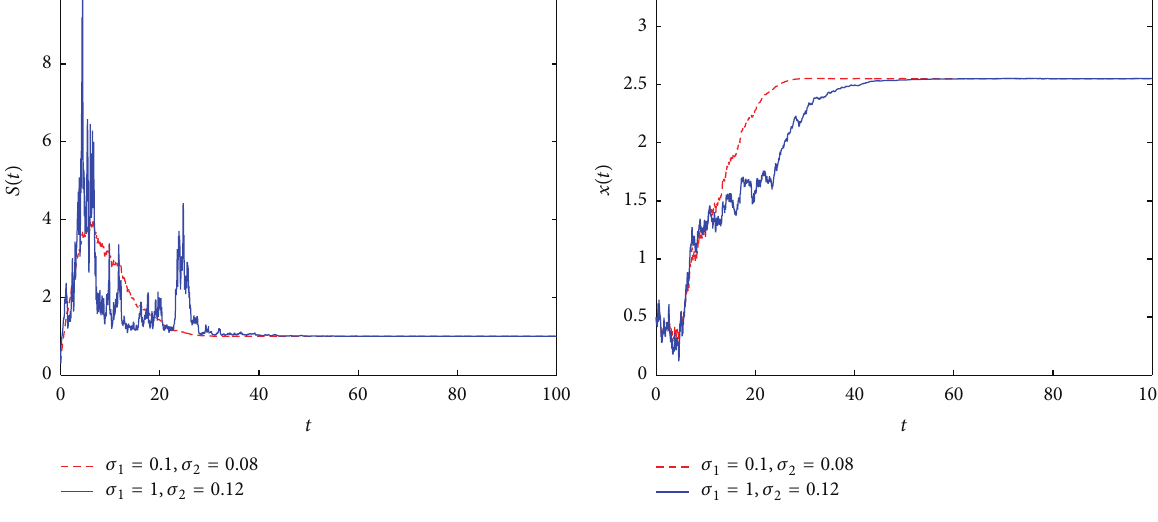
numerically by pseudorandom number generators. For